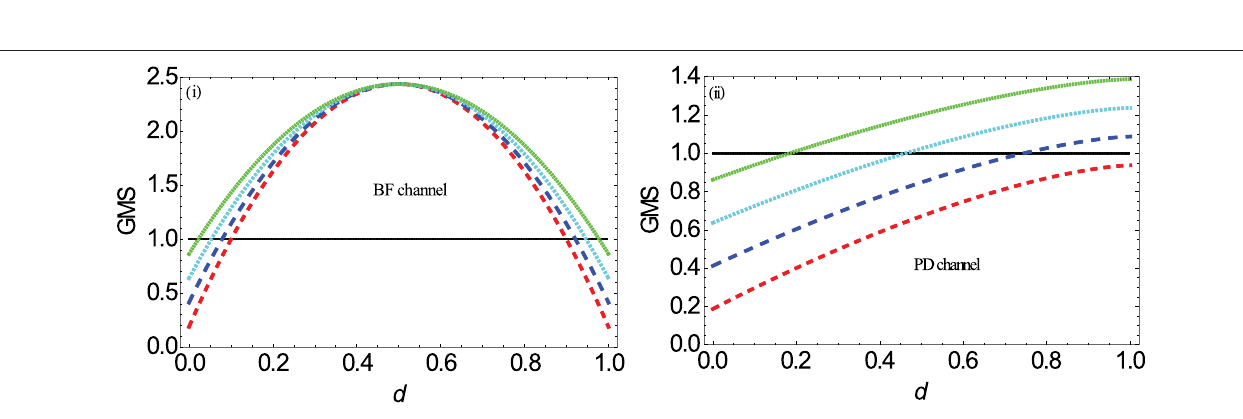
(cid:8)(cid:8) √ 2 /2 within the different noisy